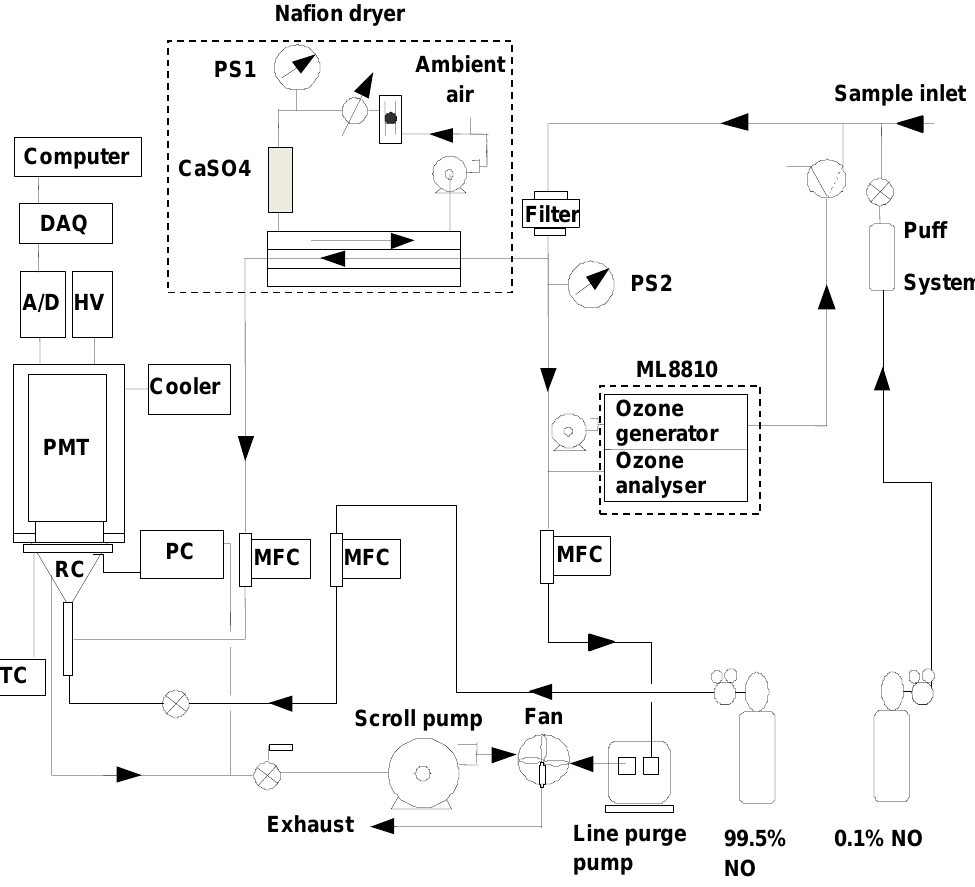
Fig. 1. Plumbing diagram of the ozone flux instrument. Labels are as follows: A/D amplifier/discriminator, DAQ data acquisition, HV high voltage, MFC mass flow controller, PC pressure controller, PMT photomultiplier tube, PS pressure sensor, RC reaction chamber, TC thermocouple. The Nafion drying circuit, including the CaSO 4 – filled drying cartridge, was added in